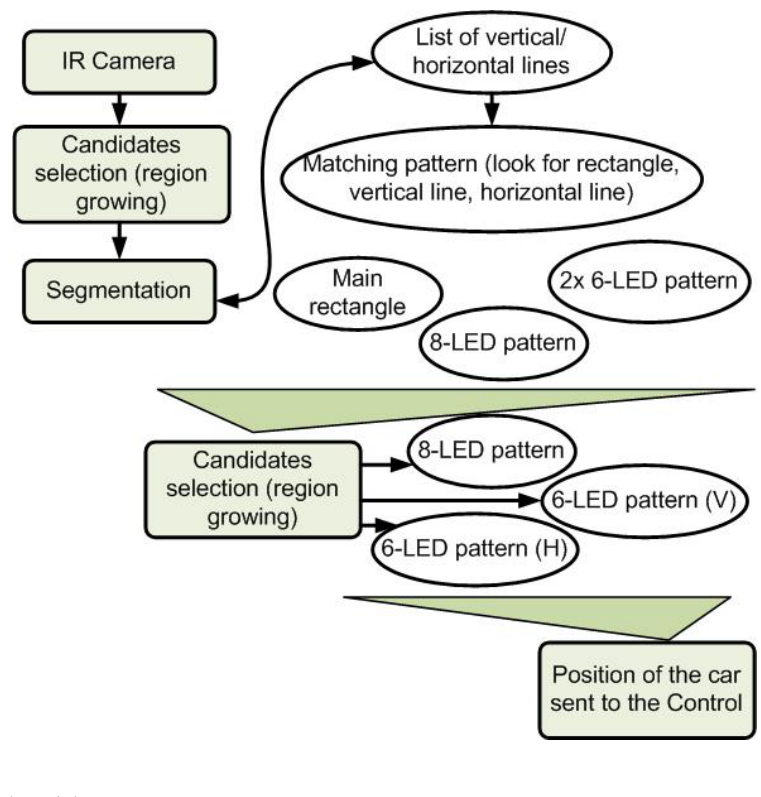
Figure 6. Summary of the perception